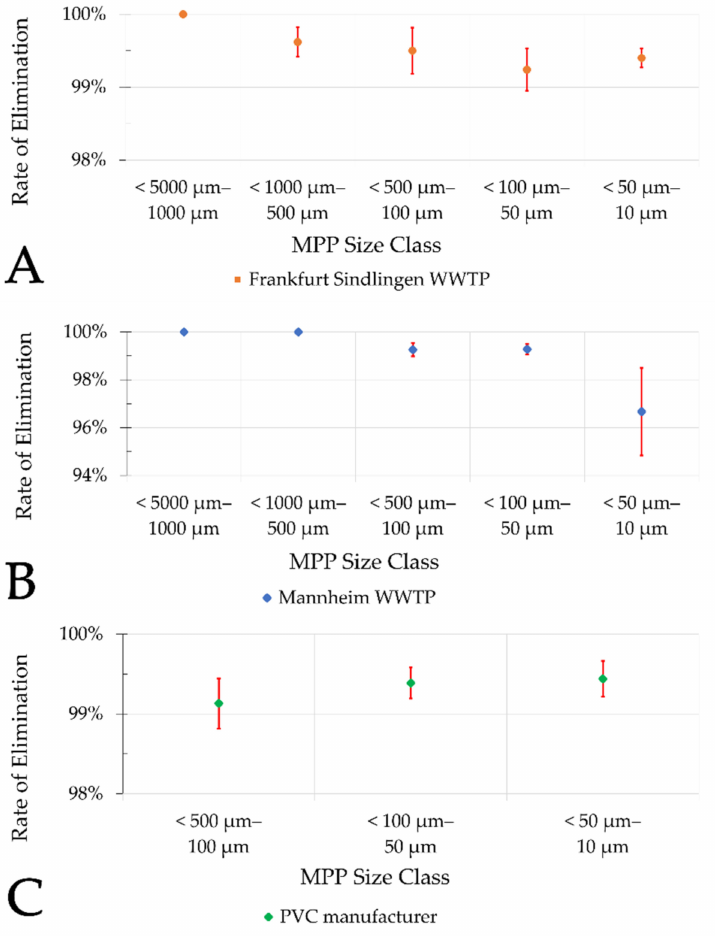
Figure 10. Average MPP elimination rates of all samples for each size class at the Frankfurt Sindlingen